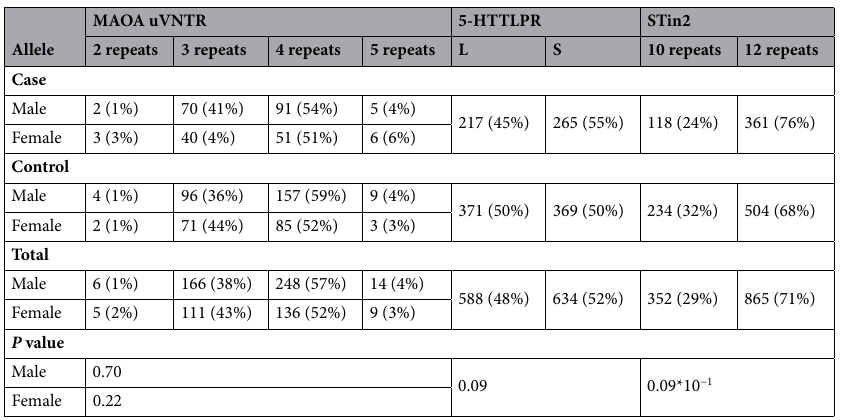
Table 3. Allele frequency of MAOA uVNTR, 5-HTTLPR and STin2.